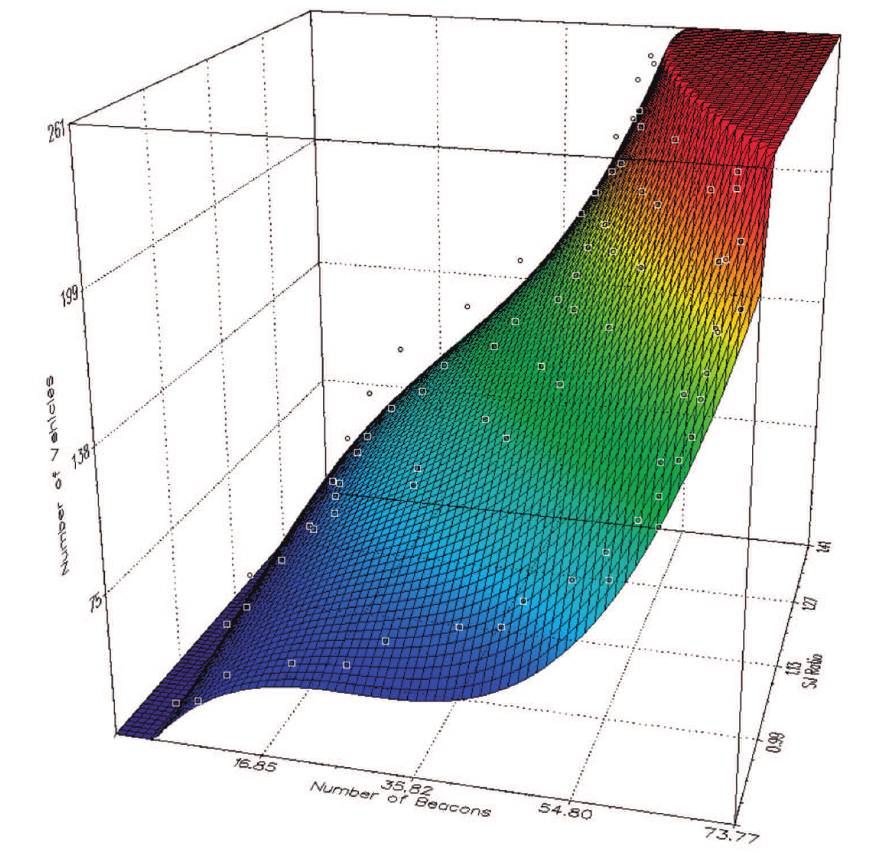
Figure 3. 3D representation of our density estimation